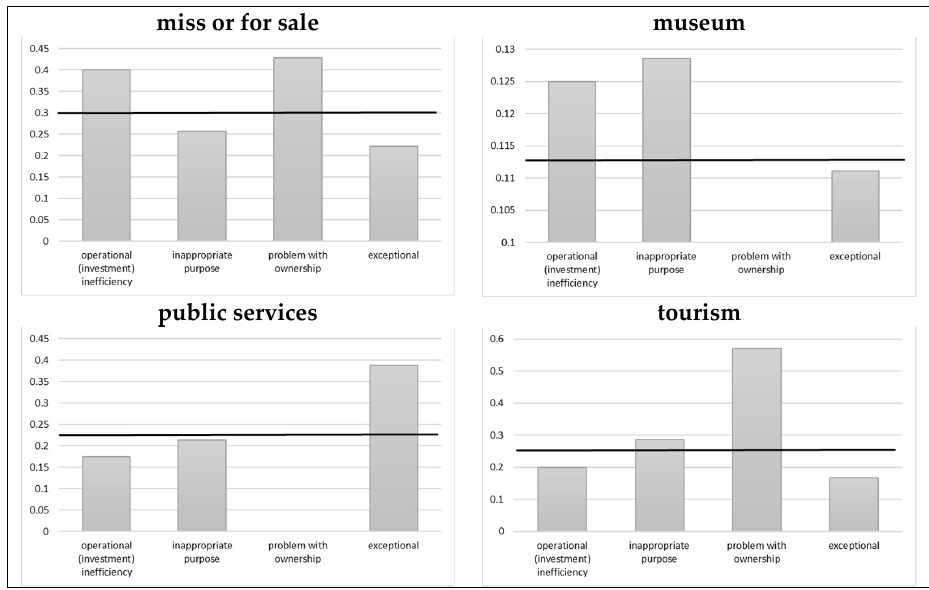
Figure 3. Causal relationship and useful function of chateau brownfields.